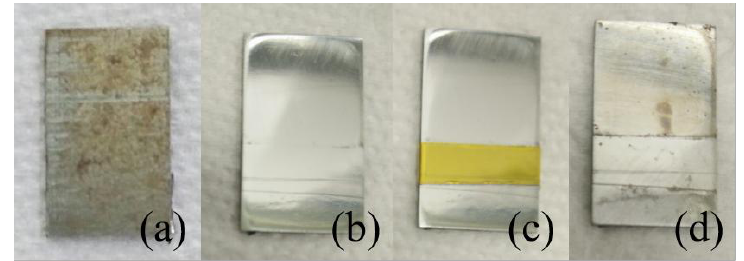
Figure 4. Photos of mild steel rust surface ( a ) before abrasion using sandpaper and ( b ) after abrasion; ( c ) 1 × 1 cm 2 working area after abrasion; and ( d ) SPAN deposited on the working area for anti-corrosion test. Here, SPAN deposited with an AN/DABSA ratio of 8.8.